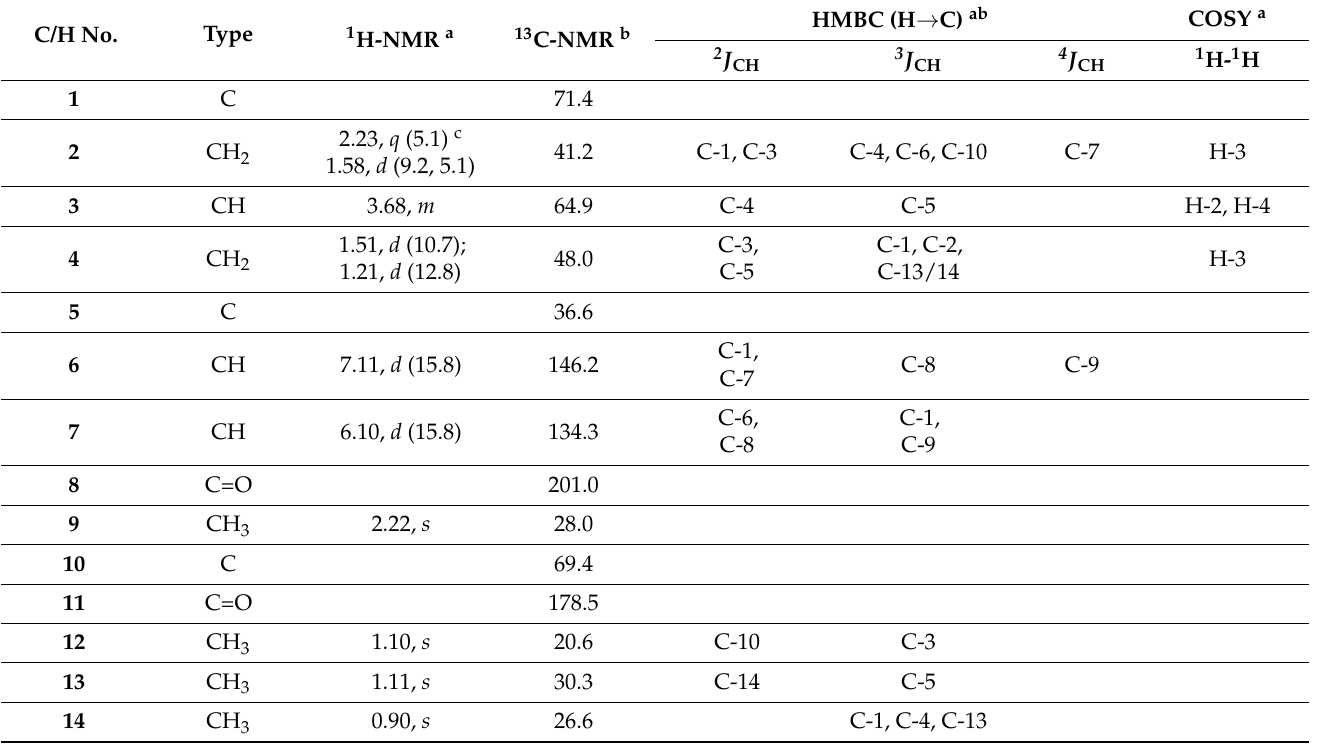
Table 1. NMR spectral data for the compound E3 in CD 3